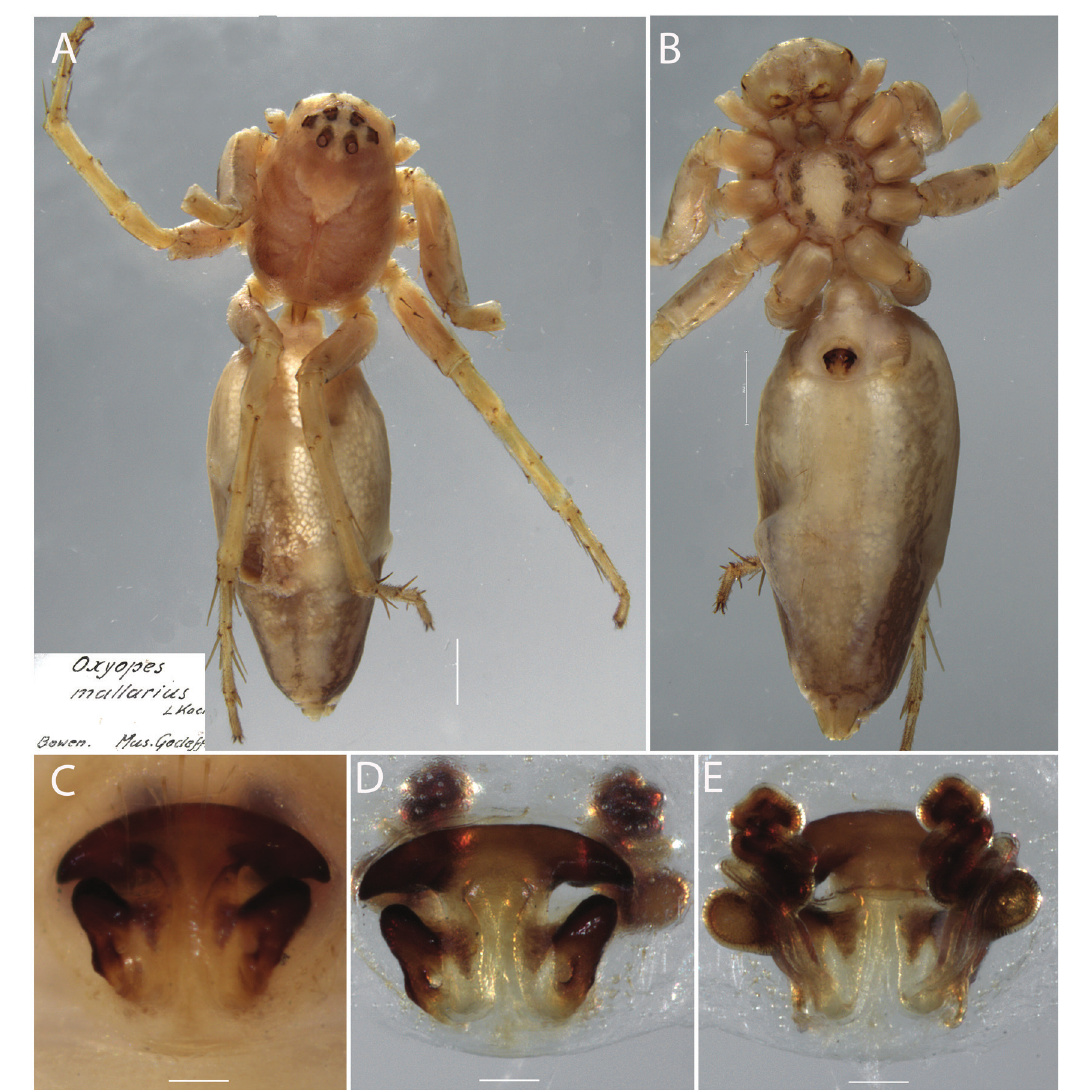
Figure 11. Oxyopes molarius L. Koch, 1878, female lectotype (ZMH- A0000013): A , habitus, dorsal view; B , habitus, ventral view; C , epigyne, ventral view; D, epigyne, ventral view, cleared; E , epigyne, dorsal view, cleared. Scale bars: habitus 1.0 mm, epigyne 0.1 mm.